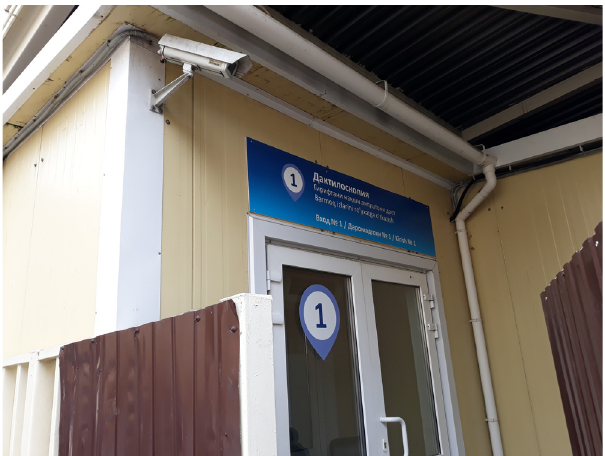
Figure 5: Entrance to the medical center, Krasnogo Tekstilshchika str., St. Petersburg, 2019, LinguaSnapp